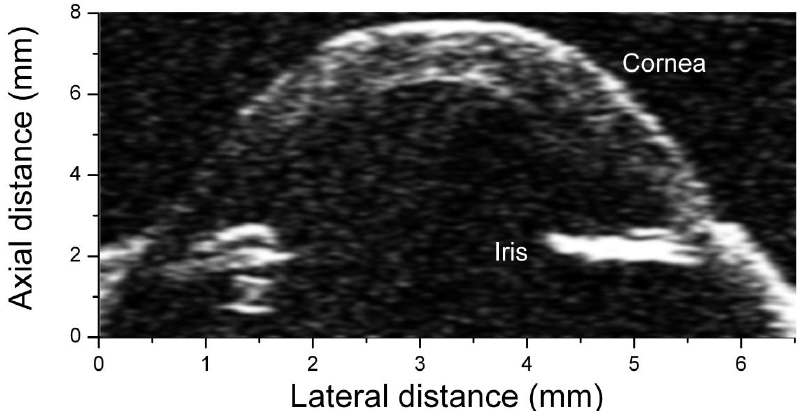
Figure 12. An image of a fish eye captured by the PIN-PMN-PT transducer (with permission from